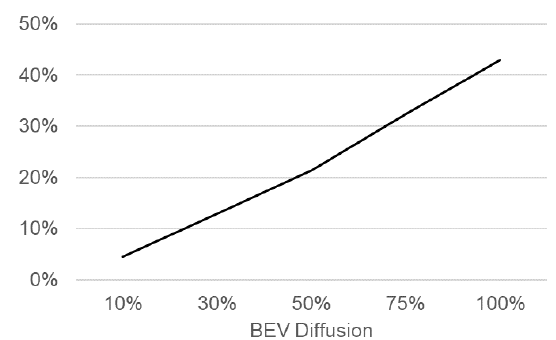
Figure 18. Increase in yearly building electricity demand through e-mobility.